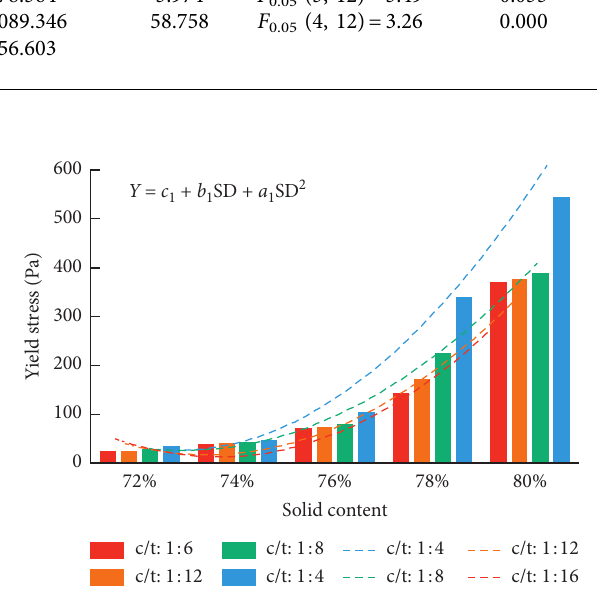
Figure 3: Histogram between SD and yield stress of CUTB samples.